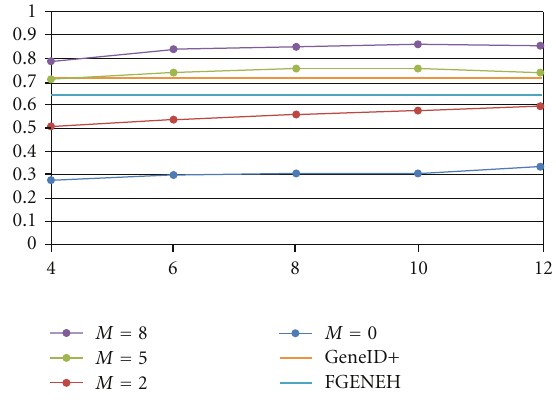
Figure 3: Maximum full-exon metastate HMM performance for data ALLSEQ.